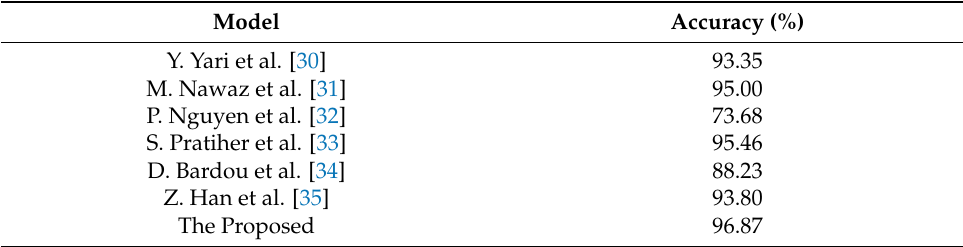
Table 4. Classification accuracy of different models.